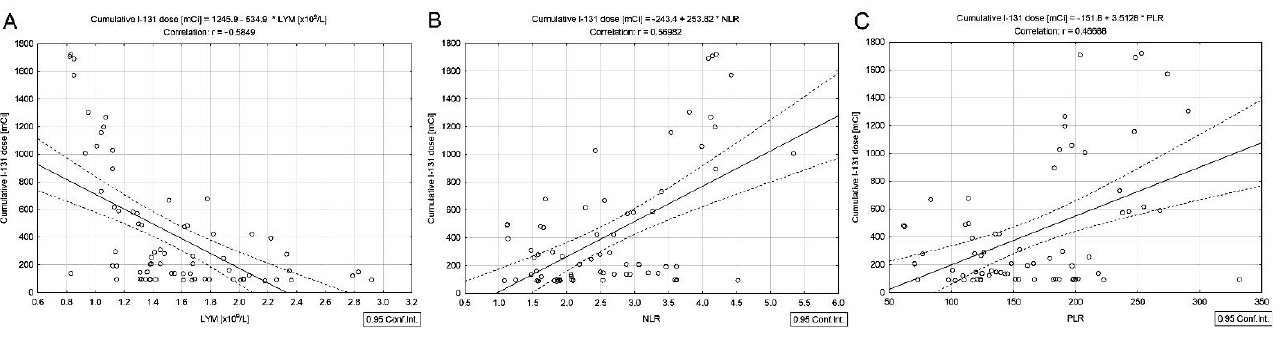
Figure 2. Correlations between the cumulative dose of 131 I and absolute lymphocyte count ( A ), NLR ( B ), and PLR ( C ) in differentiated thyroid cancer patients without type 2 diabetes mellitus. However, the LVEF was positively correlated with absolute lymphocyte count ( r = 0.44, p < 0.001) (Figure 3A) and serum Ca 2+ ( r = 0.29, p = 0.012) and negatively with NLR and PLR ( r = − 0.56 and r = − 0.42, p < 0.001) (Figure 3B,C).